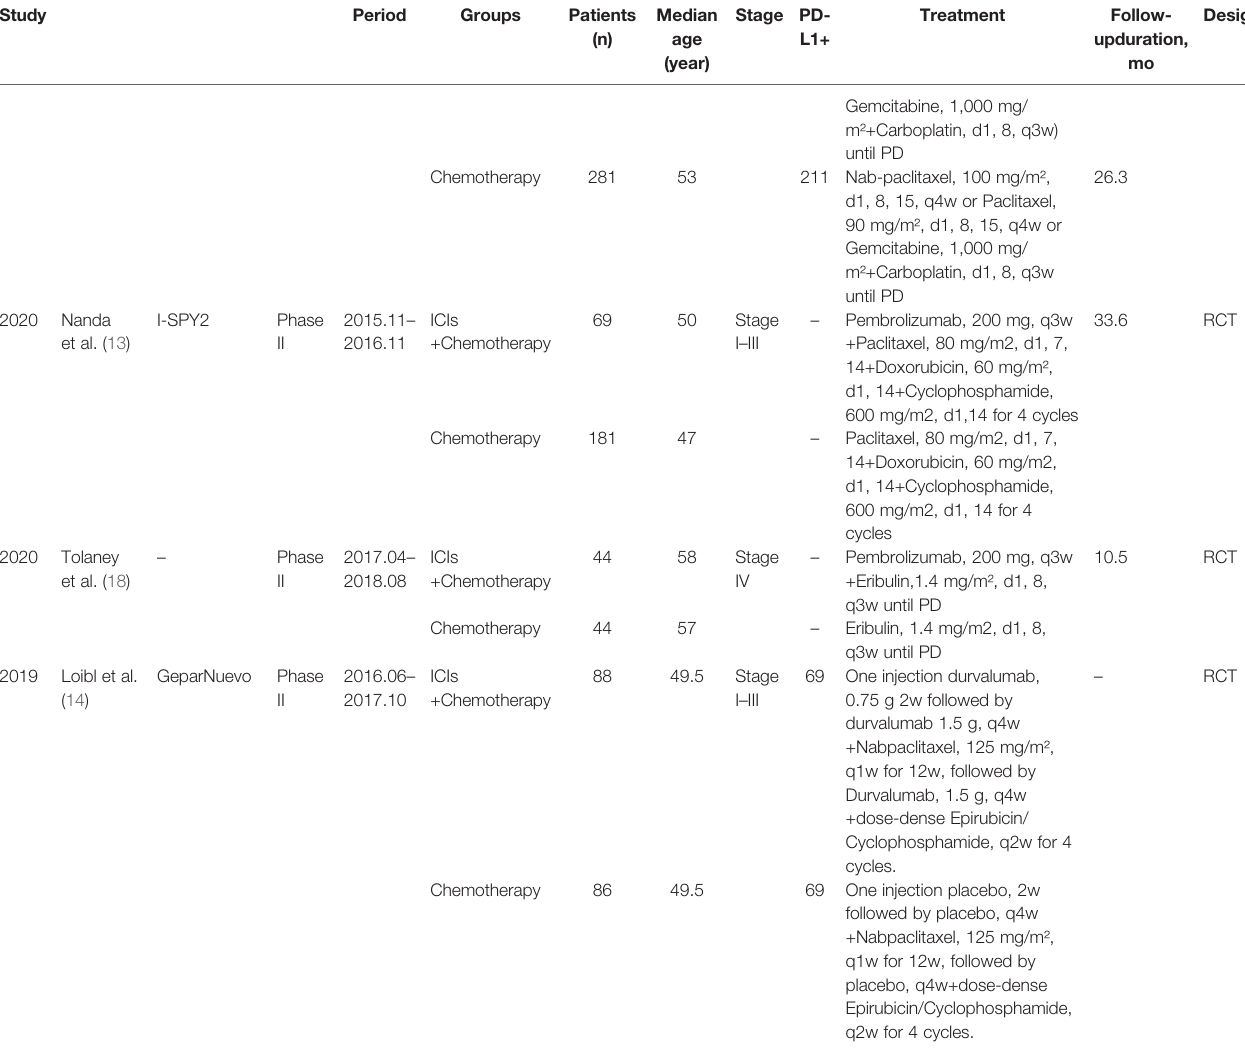
Figure 2 ). At all points in time, the progression-free survival rate (PFSR) signi fi cantly favored the ICIs+Chemotherapy